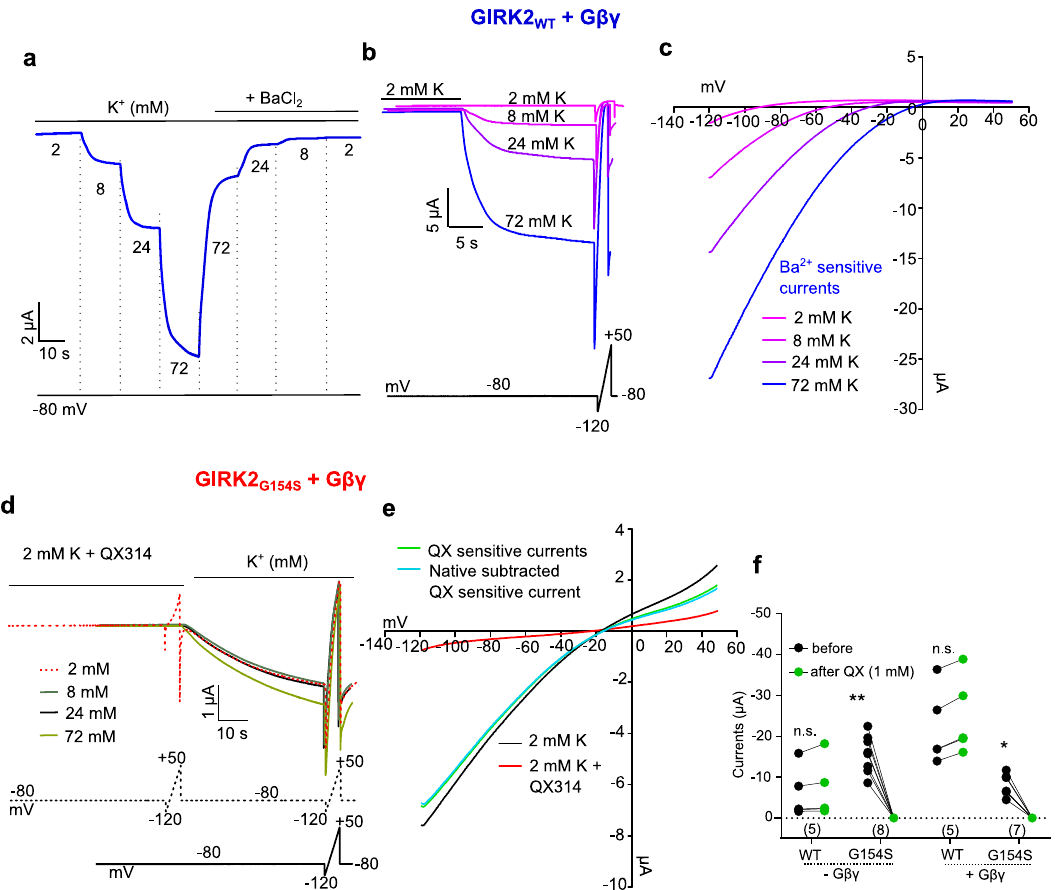
Fig. 3 hGIRK2 G154S compared to hGIRK2 wt . a Representative of whole cell current records from hGIRK2 wt with G βγ . Sequential changes of solutions and subsequent Ba 2 + block are shown. The holding potential was − 80 mV, and the recording always started in low-K + (2 mM) solution. b Representative recordings of whole-cell currents from hGIRK2 wt with G βγ . 2 s voltage ramps from − 120 to + 50 mV are performed in each solution. Record from each solution is shown in a different color. Voltage protocol is shown in the lower panel. c I – V curves in a representative oocyte expressing hGIRK2 wt with G βγ tested in four solutions. Ba 2 + sensitive currents are shown. d Representative recordings of whole-cell currents from hGIRK2 G154S with G βγ . 2 s voltage ramps from − 120 mV to + 50 mV are performed in each solution. e I-V curves in a representative oocyte expressing hGIRK2 G154S with G βγ in the 2 mM K + solution (black) along with QX block (red), QX sensitive currents (green) and the net QX currents obtained from subtracting average native currents from QX sensitive currents (cyan) are shown. f hGIRK2 wt and hGIRK2 G154S currents with and without G βγ , before and after QX314 (1 mM) application, in 4 – 7 oocytes from one frog, are shown. Paired t -test followed by Wilcoxon test was performed. ** p = 0.0078 and * p = 0.0156; n.s. is not signi fi cant ( p >